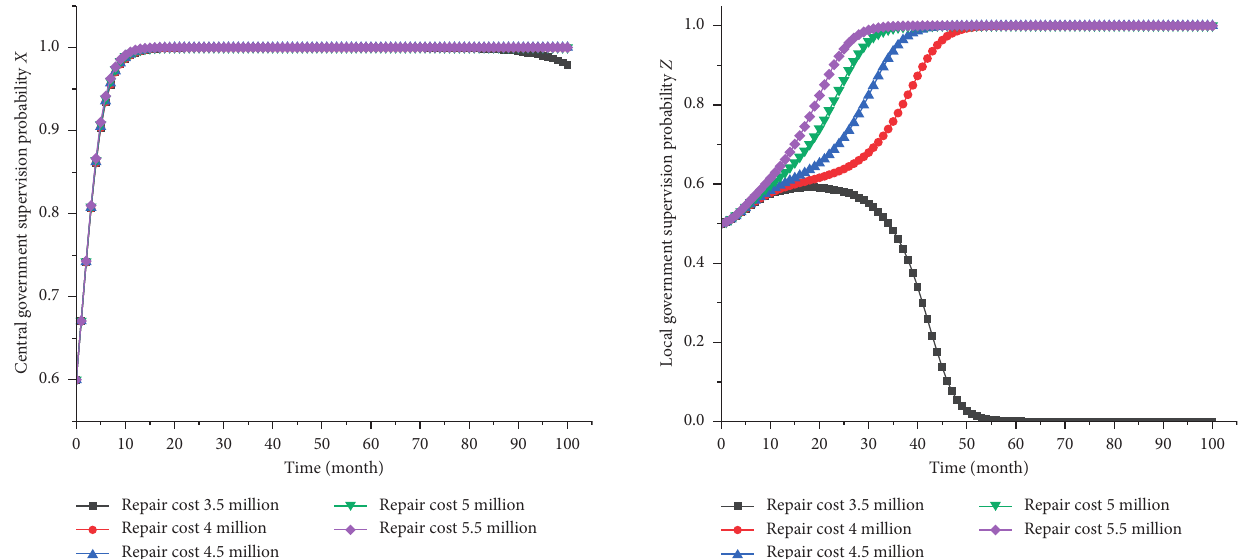
Figure 5: Impact of repair costs on local government strategy choices.